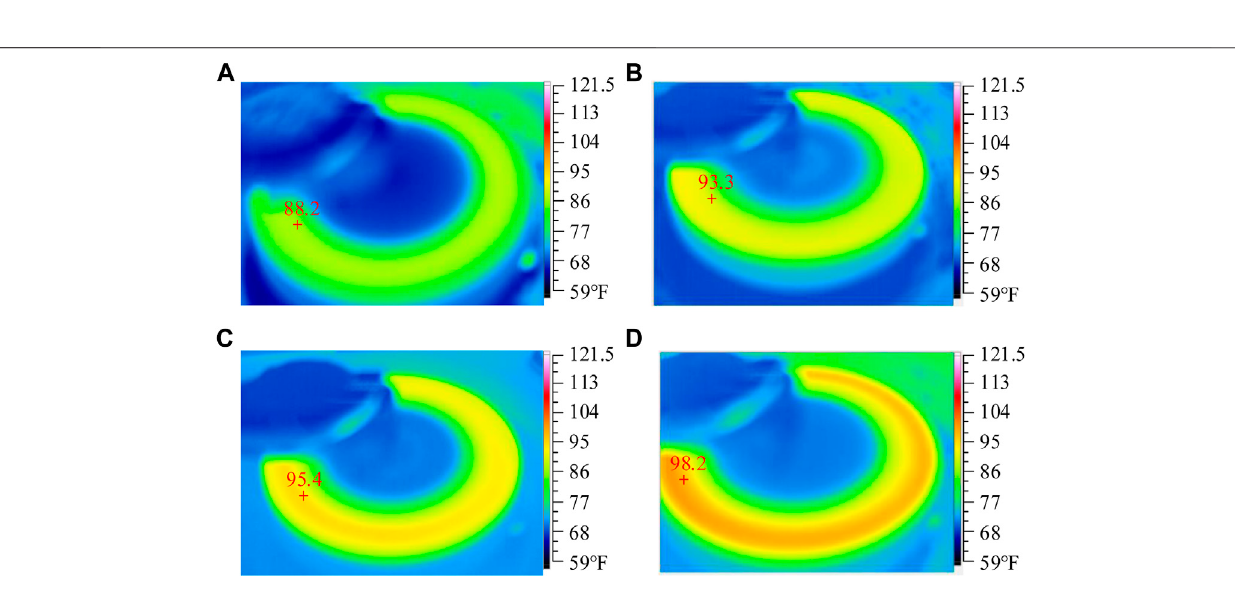
Frontiers in Materials |